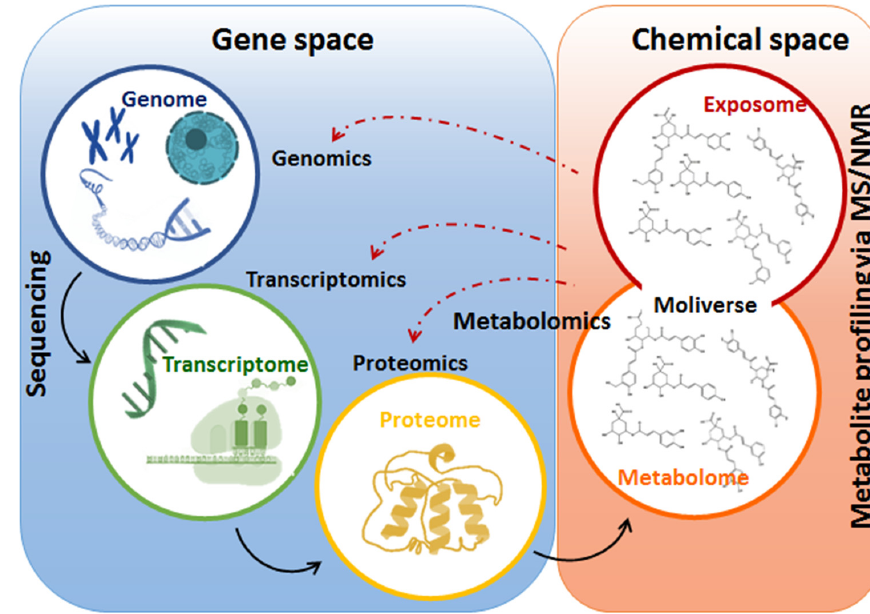
Figure 3. Summary of the omics disciplines comprising systems biology . The figure illustrates the flow of biological information from gene to metabolome, highlighting the interconnection of gene and chemical spaces of a biological system. In a stressful event, gene expression is altered, and chemical spaces are reprogrammed to maintain cellular and molecular life-defining equilibria. At the metabolome level, changes in the levels of primary and secondary metabolites play an important role in the readjustment of cellular metabolism towards adaptation to various environmental conditions.